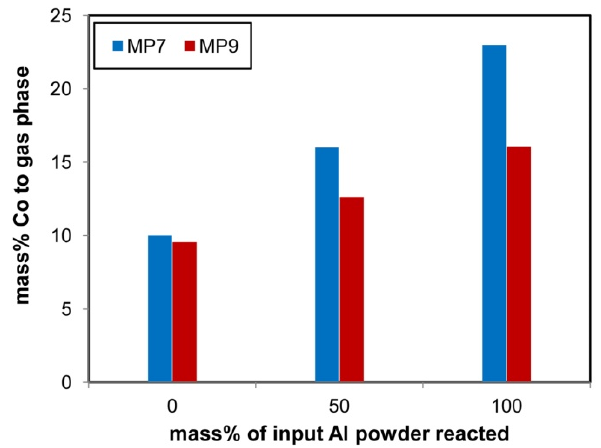
Figure 9. Expected cobalt loss to gas according to gas ‐ slag ‐ metal powder equilibrium at 2500 °C: MP7 to MP9 comparison.